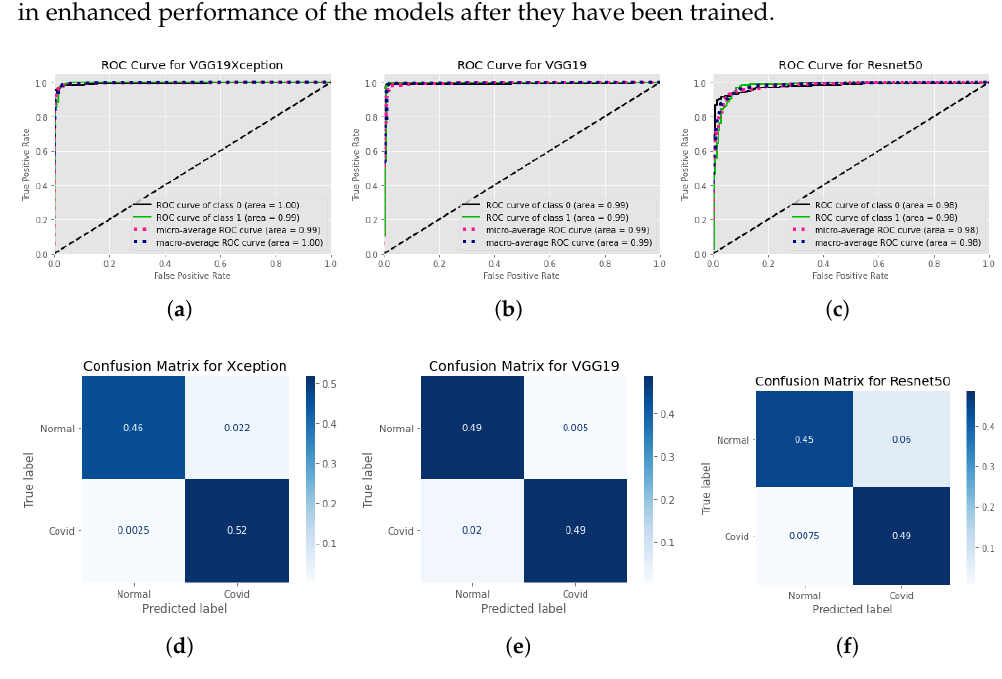
Figure 10. ROC curves and confusion matrices for each of the models, considering each of the classes individually while training the model with 512 × 512 input image resolution. ROC curves are at the top Normalized confusion matrices are at the bottom. Left: Xception model’s ROC curve and confusion matrices. Center: Confusion matrices and the ROC curve of the VGG19 model. And finally at right: Resnet model’s ROC curve and confusion matrices. ( a ) ROC curve for Xception model at input image resolution 512 × 512, ( b ) ROC curve for VGG19 at input image resolution 512 × 512, ( c ) ROC curve for Resnet50 at input image resolution 512 × 512, ( d ) Confusion Matrix for Xception model at input image resolution 512 × 512, ( e ) Confusion Matrix for VGG19 at input image resolution 512 × 512, ( f ) Confusion Matrix for Resnet50 at input image resolution 512 ×